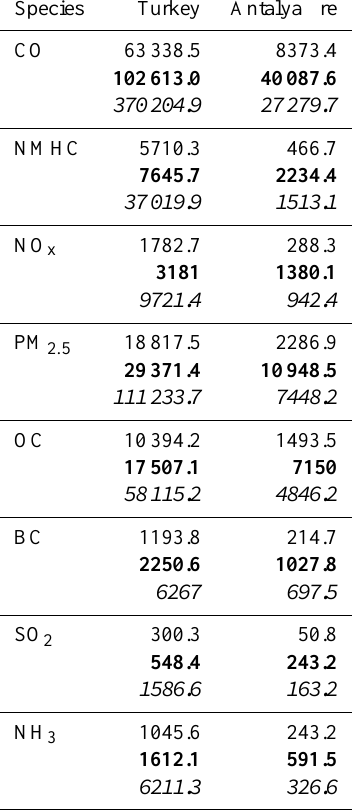
Table 2. Total fire emission estimates of the principal pollutants [tons] in the study area and for Antalya fire from WF_ABBA and LSA SAF FRP-pixel products and GFASv1.1 during Antalya fire lifetime (31 July and 5 August 2008). The GFASv1.1 values are italic below the value for WF_ABBA and LSA SAF FRP-pixel (in bold) based